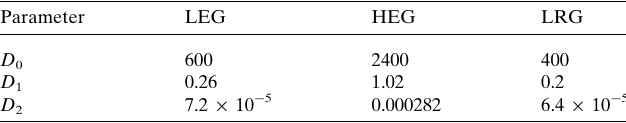
Table 1 Main parameters of the three gratings of the MERLIN